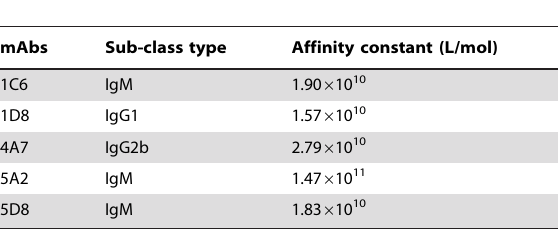
Table 3. The characteristics of mAbs against E. coli O157:H7.